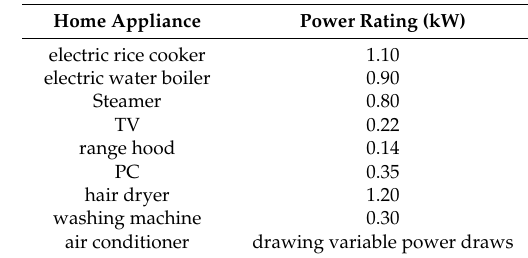
Table 2. Monitored home appliances.